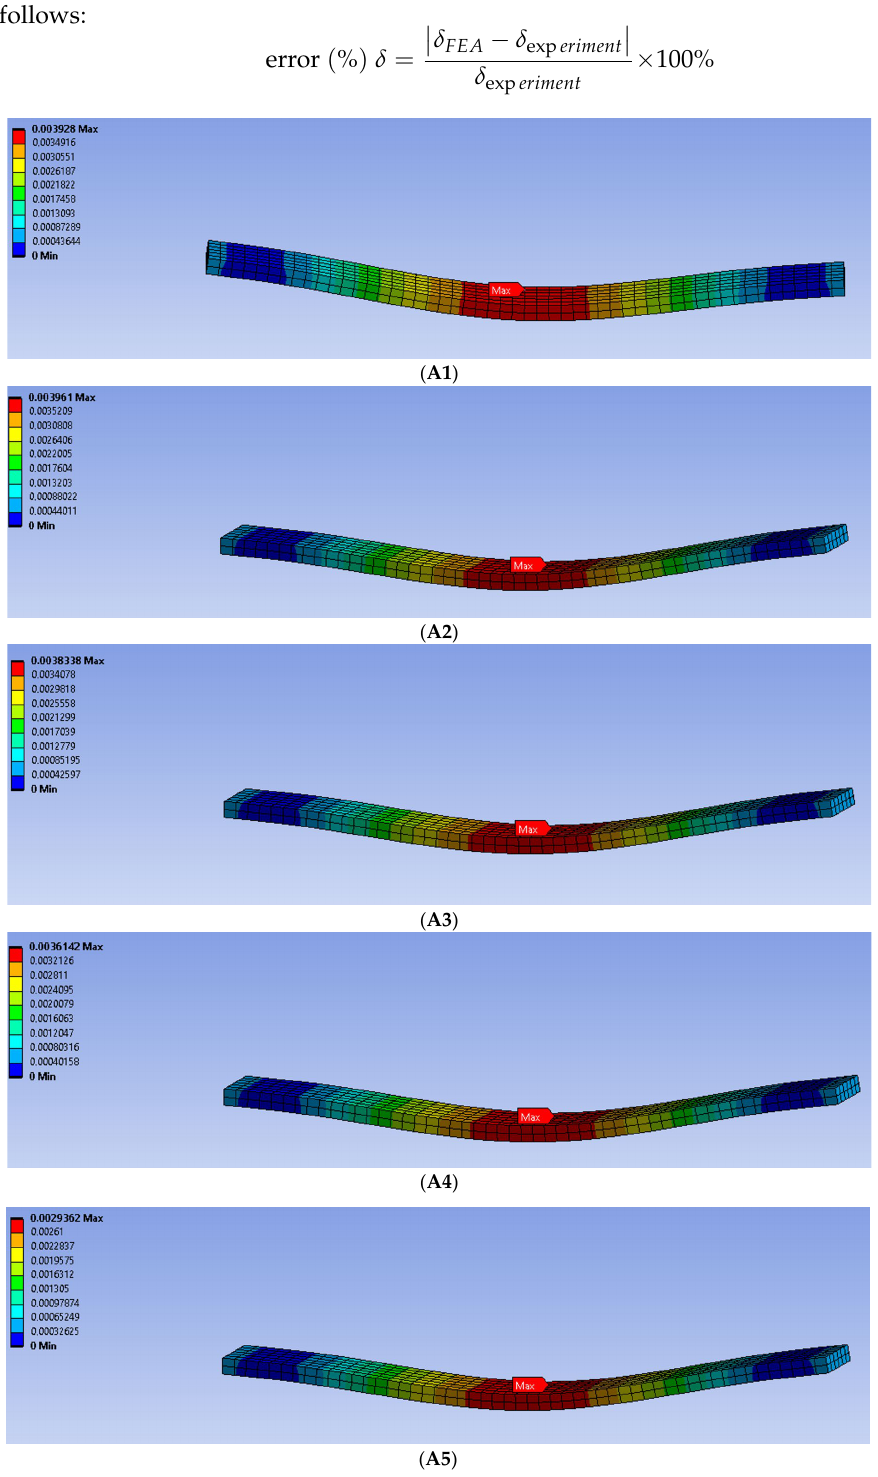
Figure 10. Deflections of the ( A1 – A5 ) PLA beams. Table 5. The deviation between experimental and FE analysis